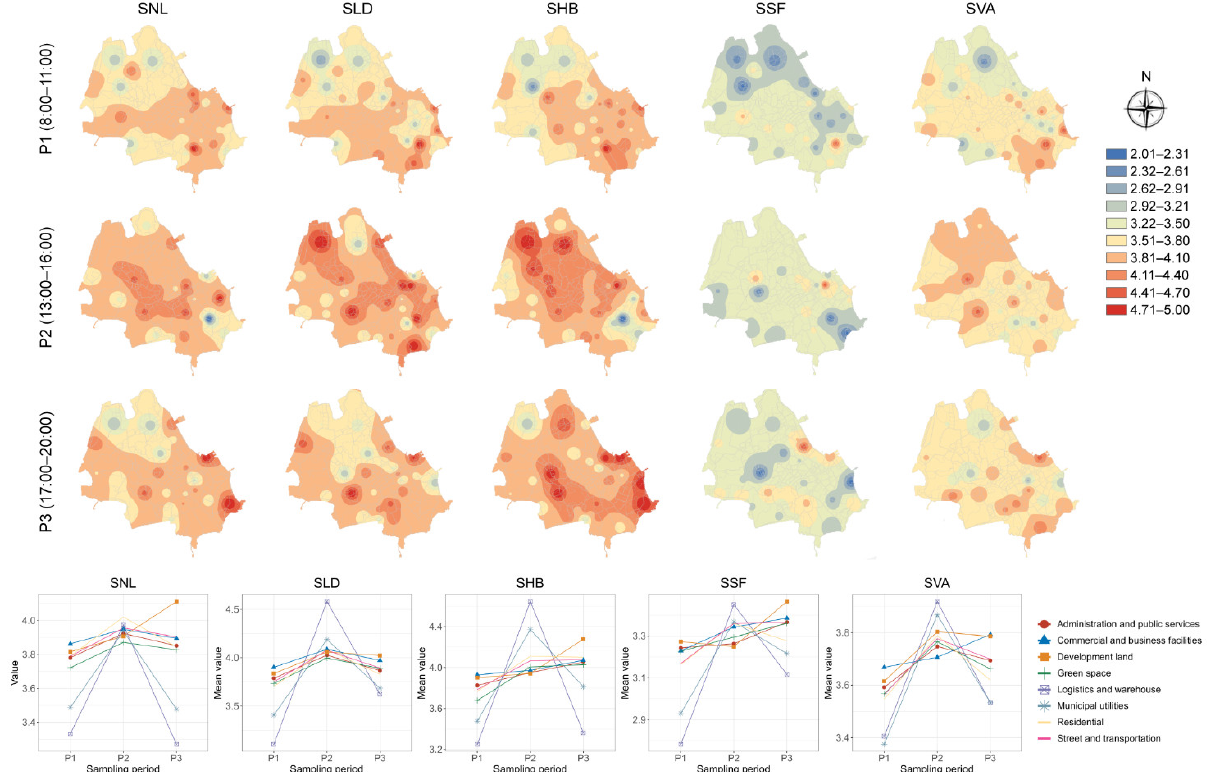
Figure 4. Spatiotemporal variation and temporal variation of the mean values of landscape satisfac- tion degree.